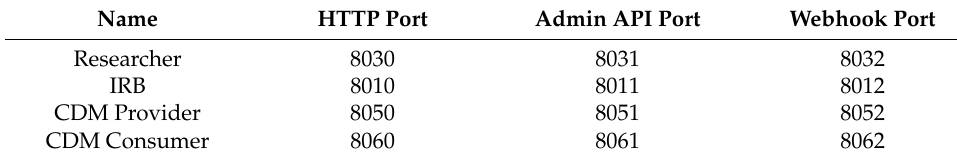
Table 3. Participating entities and their endpoints.